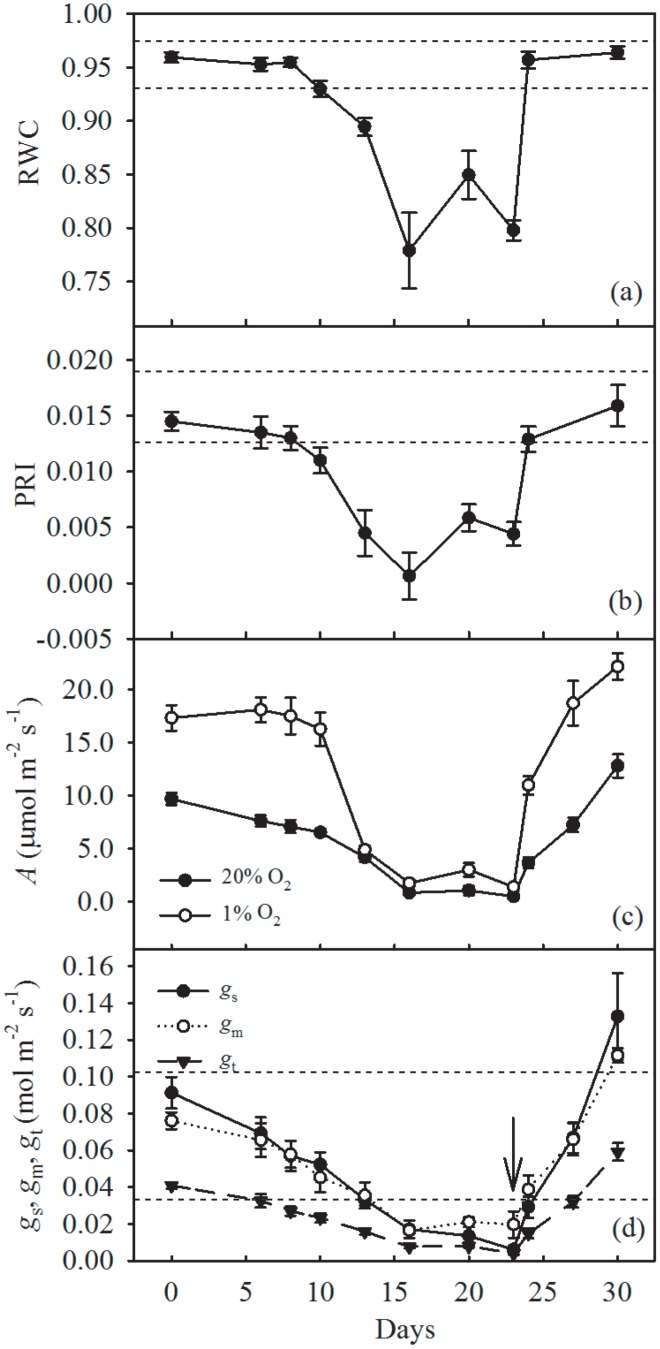
Time courses of leaf (a) relative water content (RWC), dashed horizontal lines indicate the range of values (mean ± one standard deviation) recorded in the well-watered plants over the duration of the experiment; (b) photochemical reflectance index (PRI) (dashed horizontal lines as in 1a); (c) photosynthesis (A) (measured in both ambient air and in air with 1% [O2] (A1%O2), and; (d) stomatal conductance (g
s), mesophyll conductance (g
m) and total conductance (g
t) of olive saplings grown during and after the drought cycle (days 1–23), dashed horizontal lines indicate the range of g
s values recorded in the well-watered plants. ↓  =  end of the drying cycle. Data points are means of five plants (five leaves per plant) ±1 SEM.